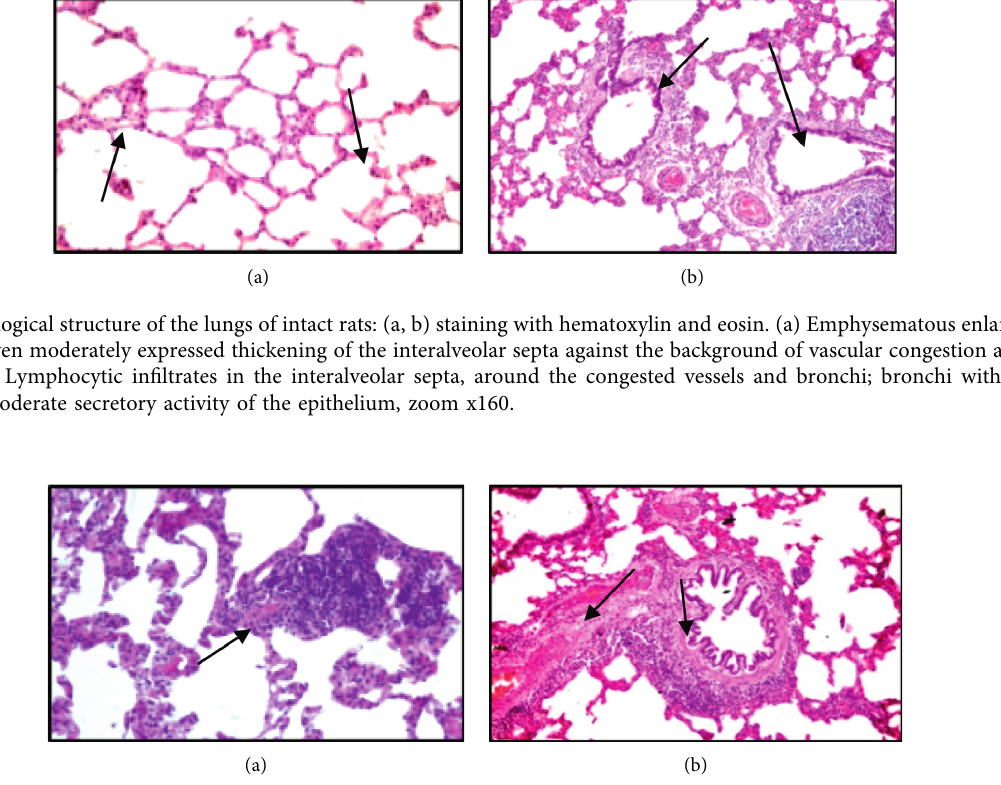
Figure 5: Histological structure of rat lungs 90days after a single irradiation at a dose of 0.2Gy in combination with exposure to coal dust every day for 4 hours. (a) Interstitial pneumonia in the form of pronounced lymphocytic infiltration of interalveolar septa, zoom x160; (b) inflammatory lymphocytic infiltration and pronounced fibrosis of the bronchial wall; peribronchial and perivascular tissues of the lung stroma, zoom